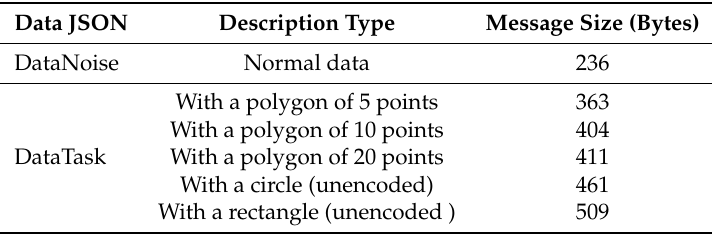
Table 2. Size of the message with different selection area and data captured